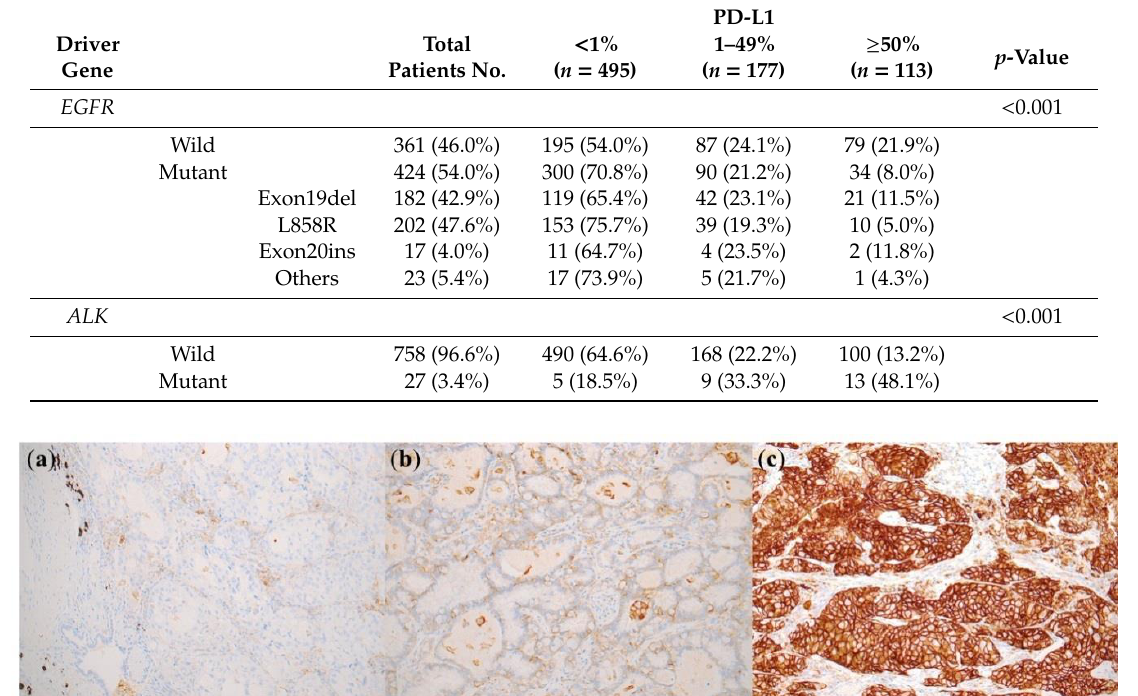
Figure1. Representative cases of PD-L1 staining (22C3) observed in ALK -positive lung adenocarcinomas. ( a ) PD-L1 negative (200×); ( b ) PD-L1 weak positive (>50%) (200×); ( c ) PD-L1 strong positive (>50%) (200×). Table 3. Association between PD-L1 expression and driver genetic status in lung adenocarcinoma.